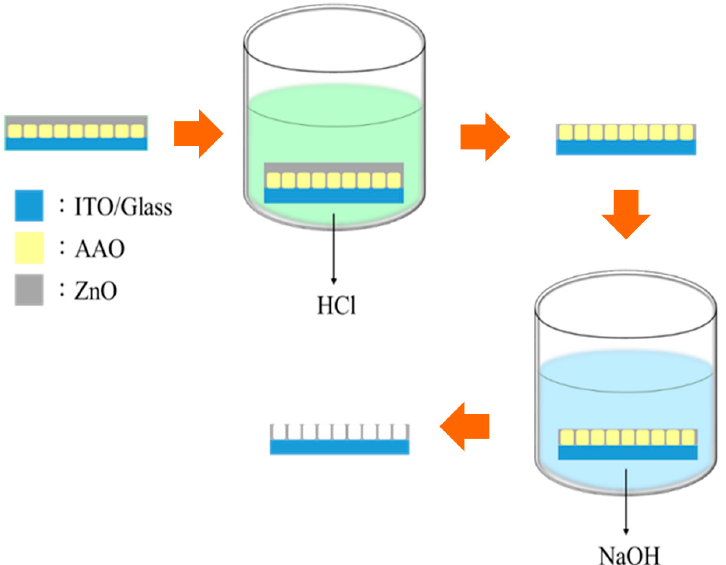
Figure 1. The process flow of removing the anodic aluminum oxide (AAO) template by the wet etching method.